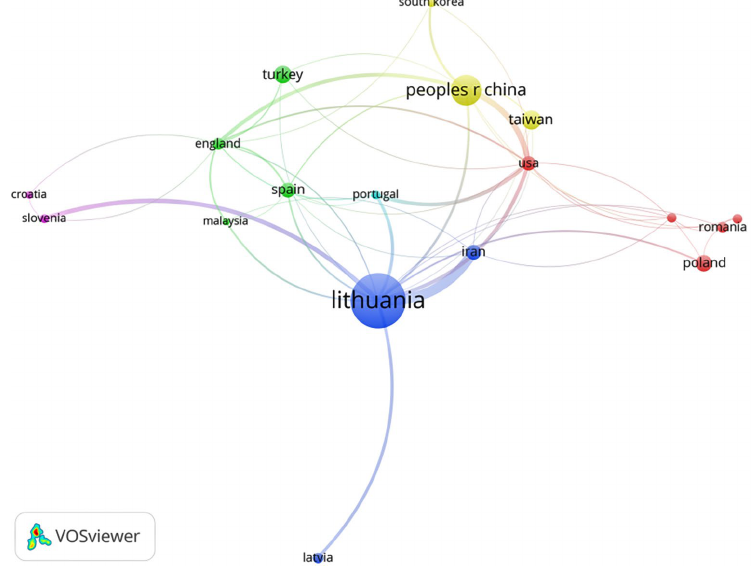
Figure 2. Countries/territories cooperation network of the TEDE